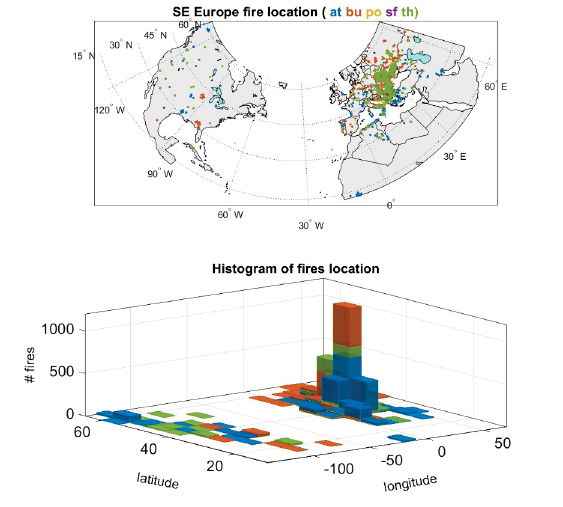
Fig. 5. SE Europe cluster (Athens, Bucharest, Potenza, Sofia, Thessaloniki). Upper plot represents the location of the fires. Lower plot represents the histogram of the number of fires’